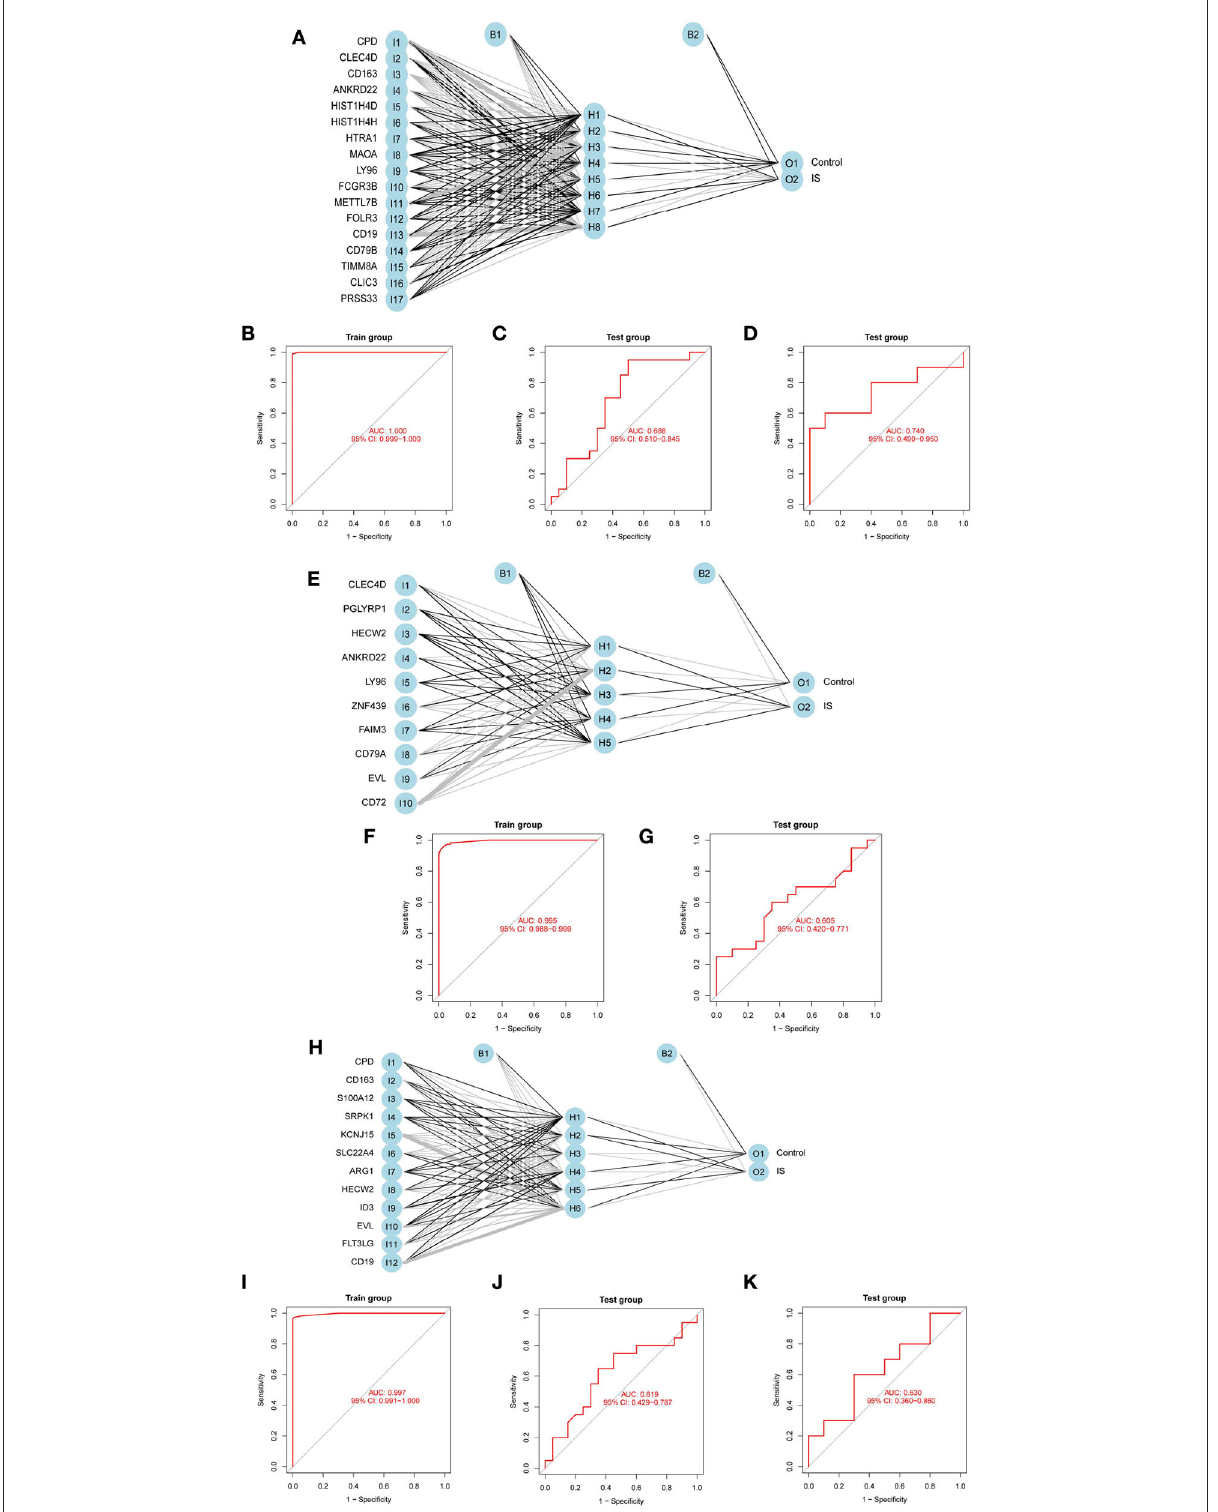
FIGURE6 Development and validation of ANN models. (A,E,H) Visualization of the LASSO + ANN, SVM-RFE + ANN, and RF + ANN models. (B–D) ROC analysis for model prediction of the LASSO + ANN in the training, GSE22255, and GSE195442 datasets. (F,G) ROC analysis for model prediction of the SVM-RFE + ANN in the training, GSE22255, and GSE195442 datasets. (I–K) ROC analysis for model prediction of the RF + ANN model in the training, GSE22255, and GSE195442